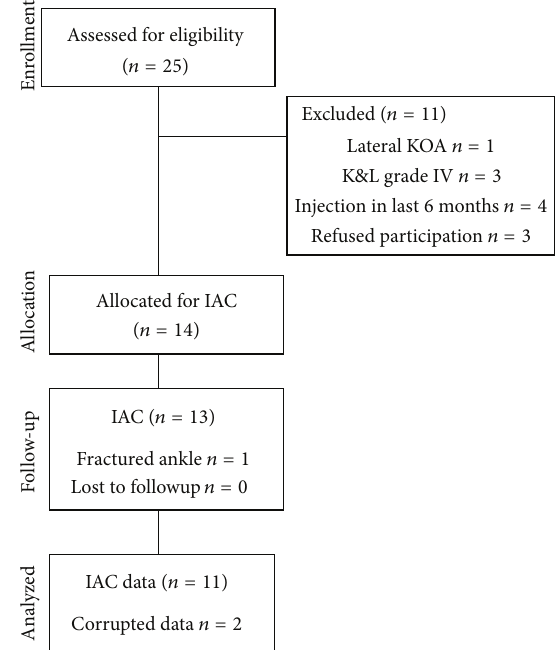
Figure 1: Flow diagram of the study (according to CONSORT statement). Diagram illustrates recruitment of patients suffering from KOA, reasons for exclusion, and the treatment received, including 6-week